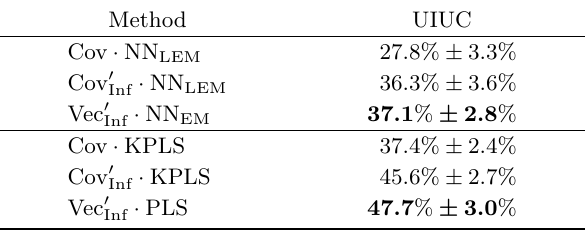
Table 1 Classification accuracies for the UIUC Material dataset